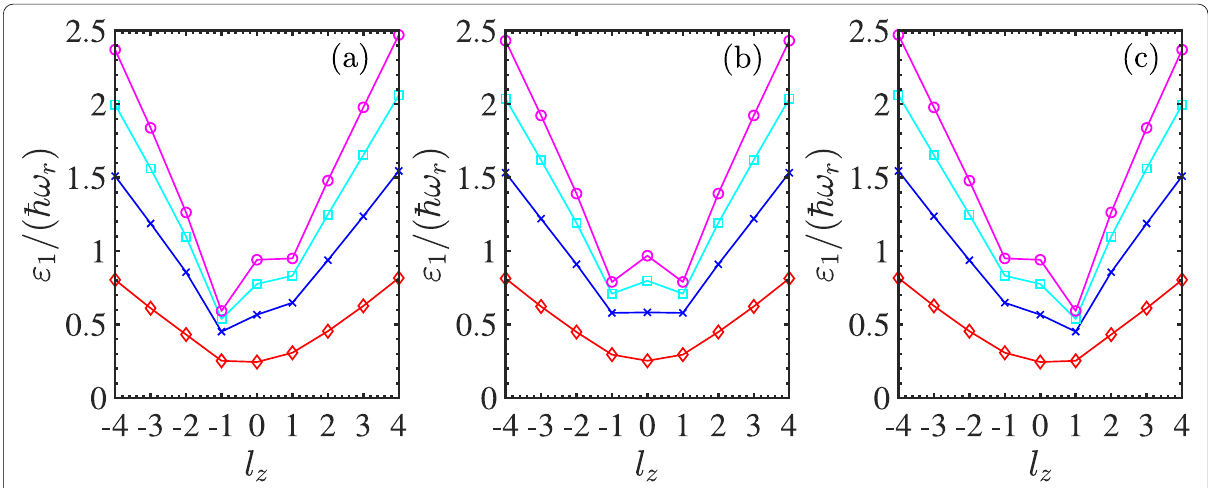
Fig. 3 Lowest energy band in the single‑particle dispersion at a negative, b zero, and c positive two‑photon detuning δ when the SOAM‑coupling strength (cid:31) R increases (top to bottom). Adapted from Ref.